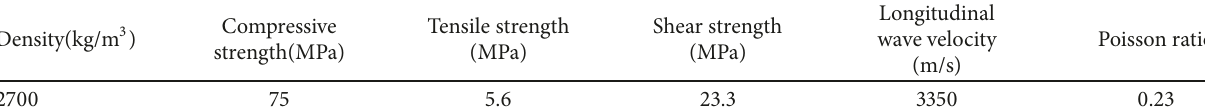
Table 1: Physical-mechanical parameters of Grade III surrounding rock.